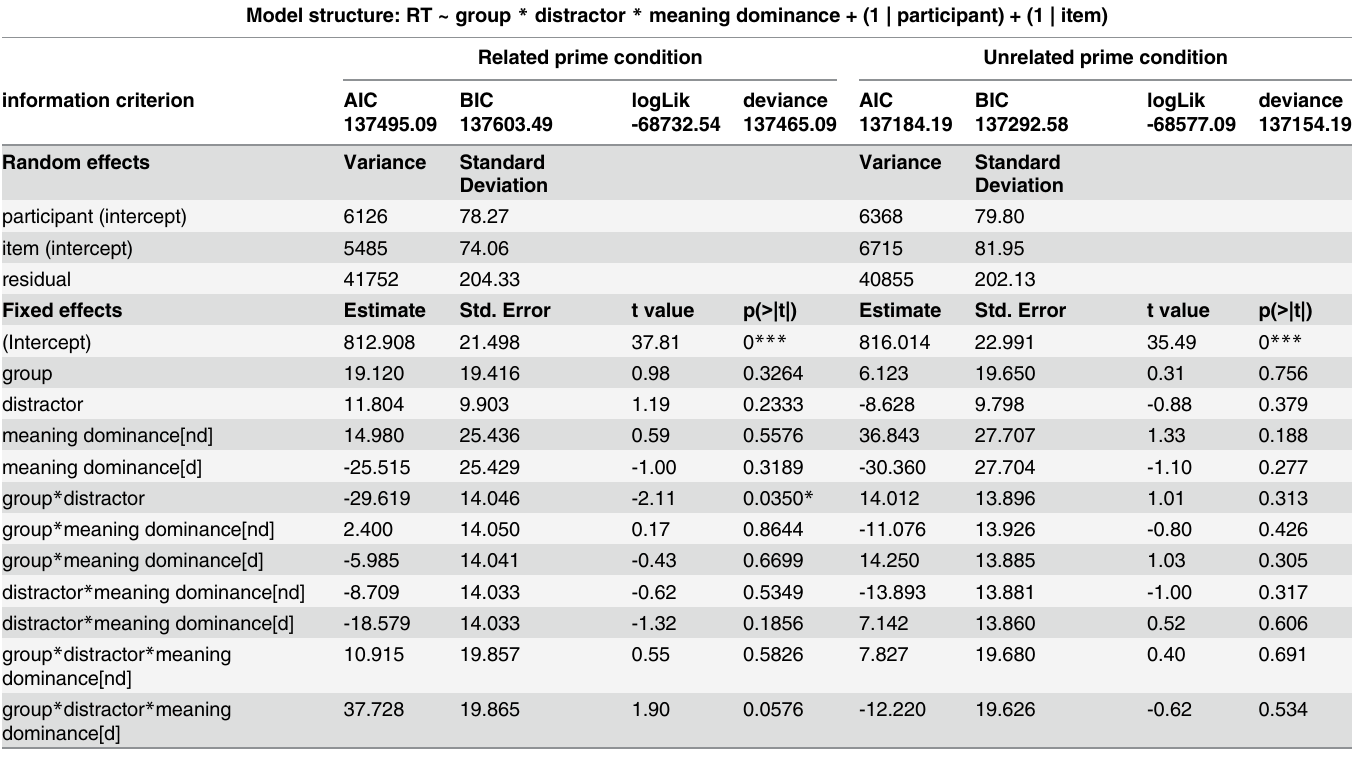
Table 3. Model summary and effect estimations of the subsequent LMMs separated for the related and unrelated prime